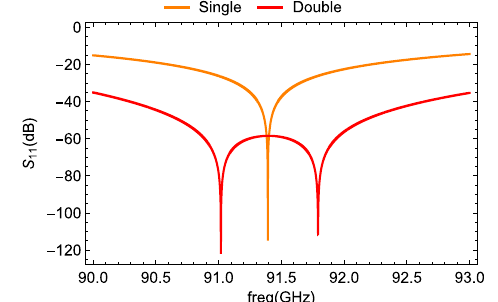
FIG. 21. Single vs double choke reflection vs frequency.